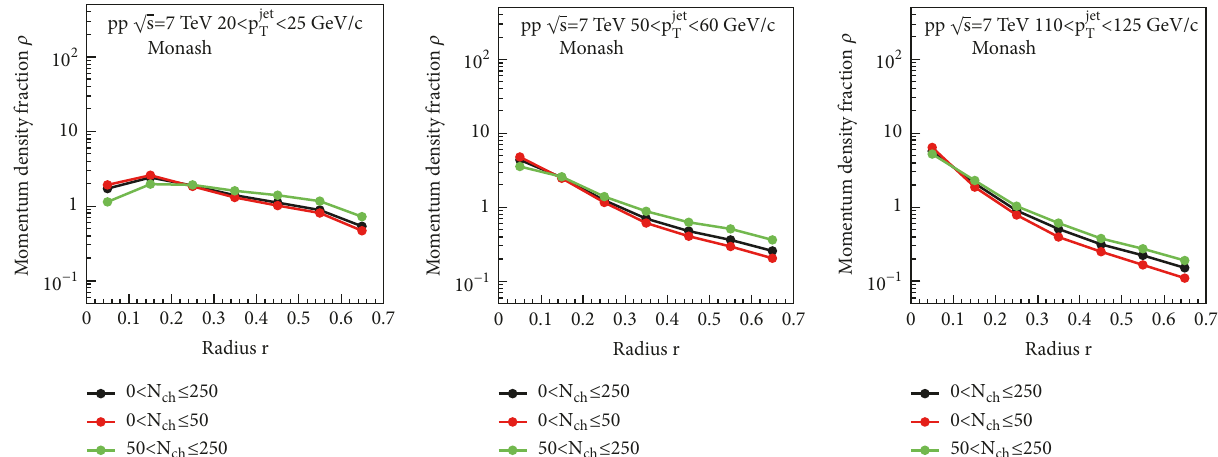
≤ 50 , red ), and ch < 60 GeV /𝑐 (center), and 110 GeV /𝑐 < T